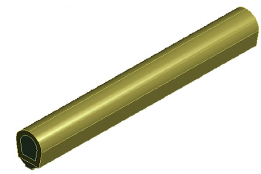
Figure 4. The structure in the modeling of the equivalent stator slots